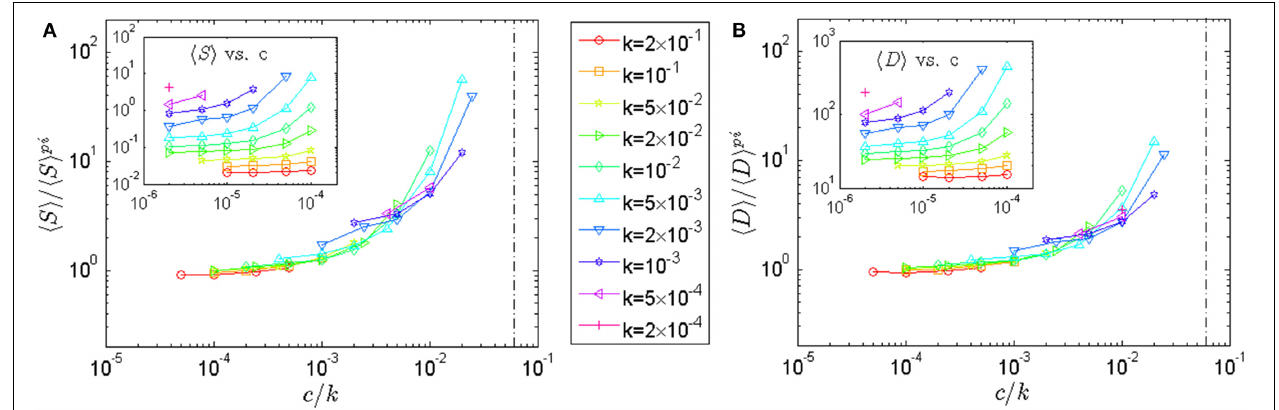
FIGURE 5 | (A) Mainpanel:Variationof (cid:4) S (cid:5) / (cid:4) S (cid:5) pi asafunctionof c / k fordifferent k . (A) Inset: (cid:4) S (cid:5) as a function of c for different k . (B) Main panel: Variation of (cid:4) D (cid:5) / (cid:4) D (cid:5) pi as a function of c / k for different k . (B) Inset: (cid:4) D (cid:5) as a function of c for different k . In both (A,B) N = 1024 and ˜ η = 1 and the axes are logarithmic. The